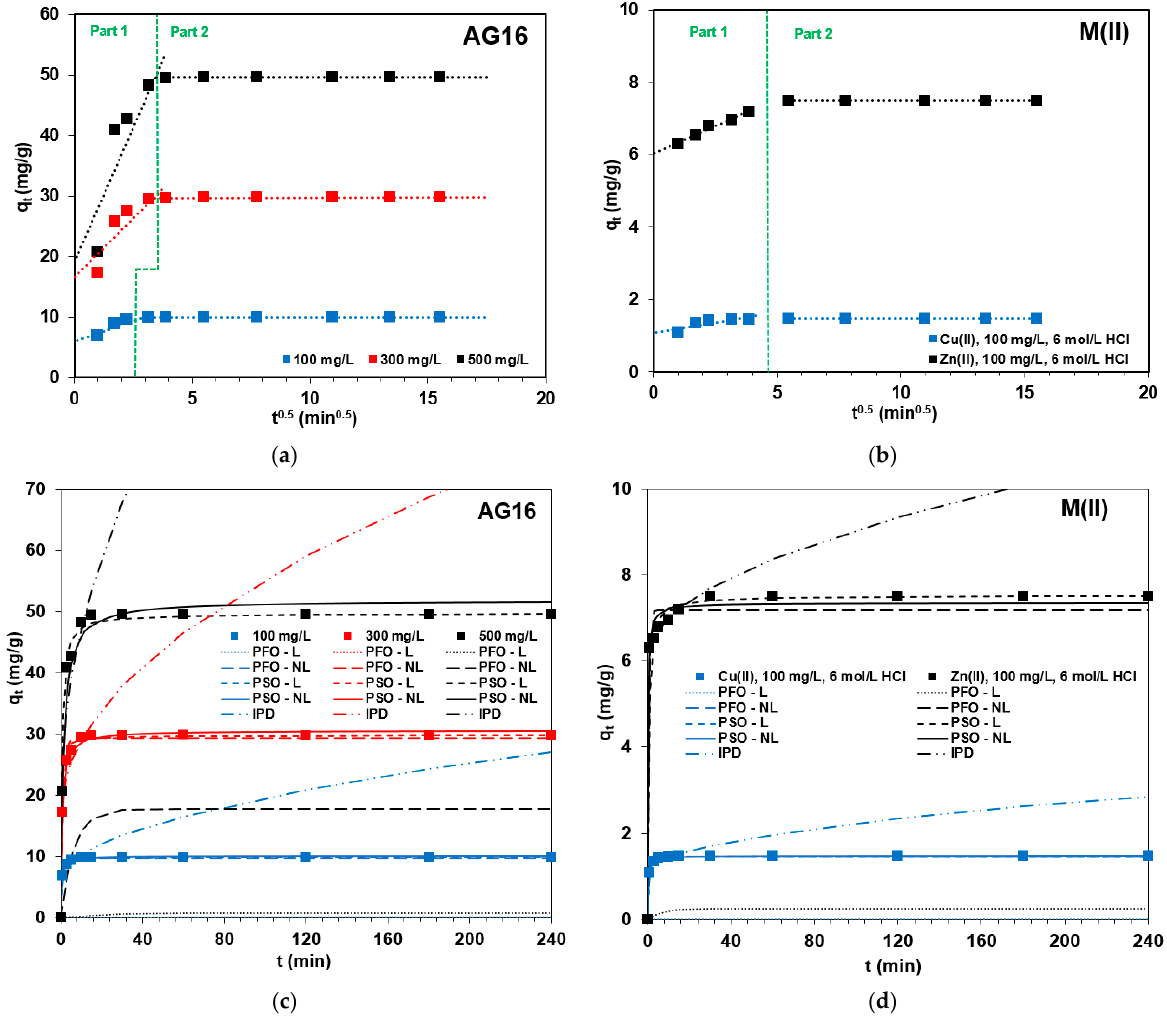
Figure 4. Intraparticle diffusion model applied for adsorption of ( a ) AG16 and ( b ) heavy metal ions as well as the fitting of the experimental data obtained for ( c ) AG16 and ( d ) heavy metals to the PFO, PSO and IPD models.